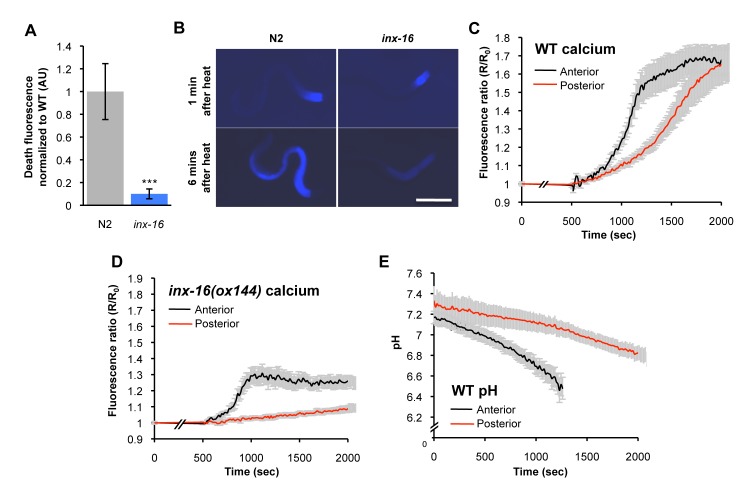
The spread of DF is dependent on calcium, and is accompanied by cytosolic acidosis.(A and B) inx-16(ox144) reduces DF and prevents its propagation (death induced using heated wire). (C–E) Ca2+ levels and pH in the intestine of worms killed by oxidative stress (t-BOOH). (C) In vivo Ca2+ levels rise at death in the anterior intestine prior to the posterior intestine, consistent with an anterior to posterior Ca2+ wave. Mean ± SD. (D) The Ca2+ reporter expressed in an inx-16(ox144) strain confirms that Ca2+, like DF, rises in the anterior but does not spread. Mean ± SD. (E) In vivo pH decreases at death from pH ∼7.35 to ∼6.6 in the anterior intestine prior to the posterior intestine, consistent with an anterior to posterior wave of cytosolic acidosis. Mean ± SD. In (C–E), “anterior” indicates the int1 and int2 anterior intestinal cells, and “posterior” the int9 posterior intestinal cells.